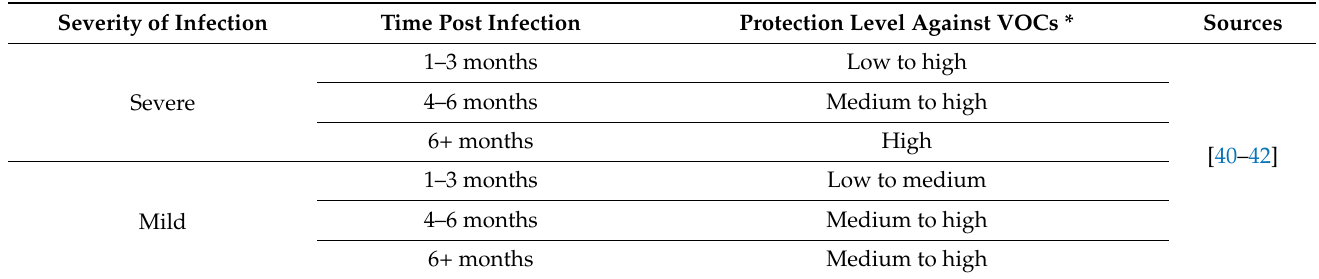
Table 3. Protection against variants of concern (VOCs) of SARS-CoV-2 from natural immunity. Severity of Infection Time Post